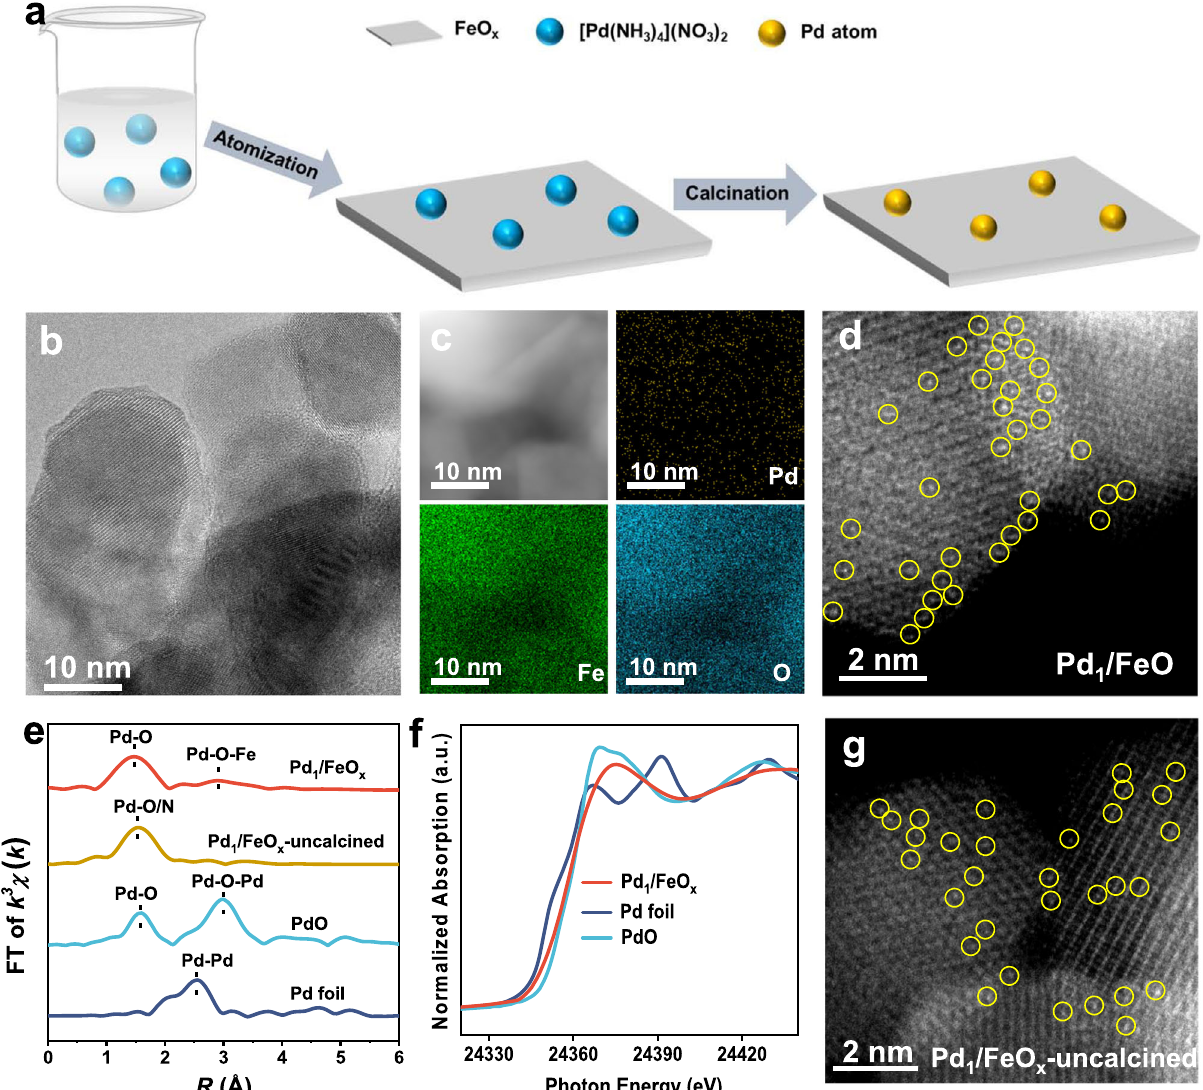
Fig. 1 | Preparation and structural characterization of Pd 1 /FeO x . a The scheme for the preparation of Pd 1 /FeO x with the precursor-atomization strategy. b TEM image of Pd 1 /FeO x . Scale bar, 10nm. c Element mapping of Pd 1 /FeO x . d ACHAADF- STEM image of Pd 1 /FeO x . Pd atoms were highlighted by yellow circles. Scale bar,